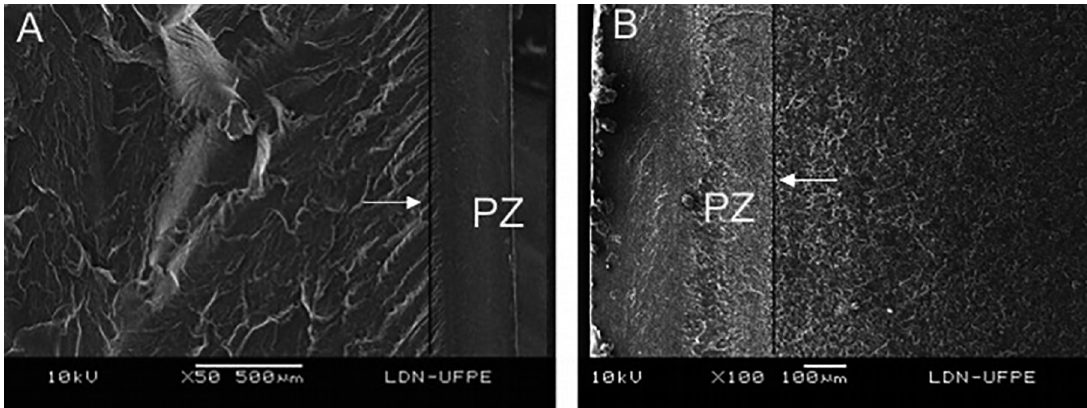
(a) and PHB (b) exposed to UV radiation during 12 weeks. The arrows indicate the 1 2